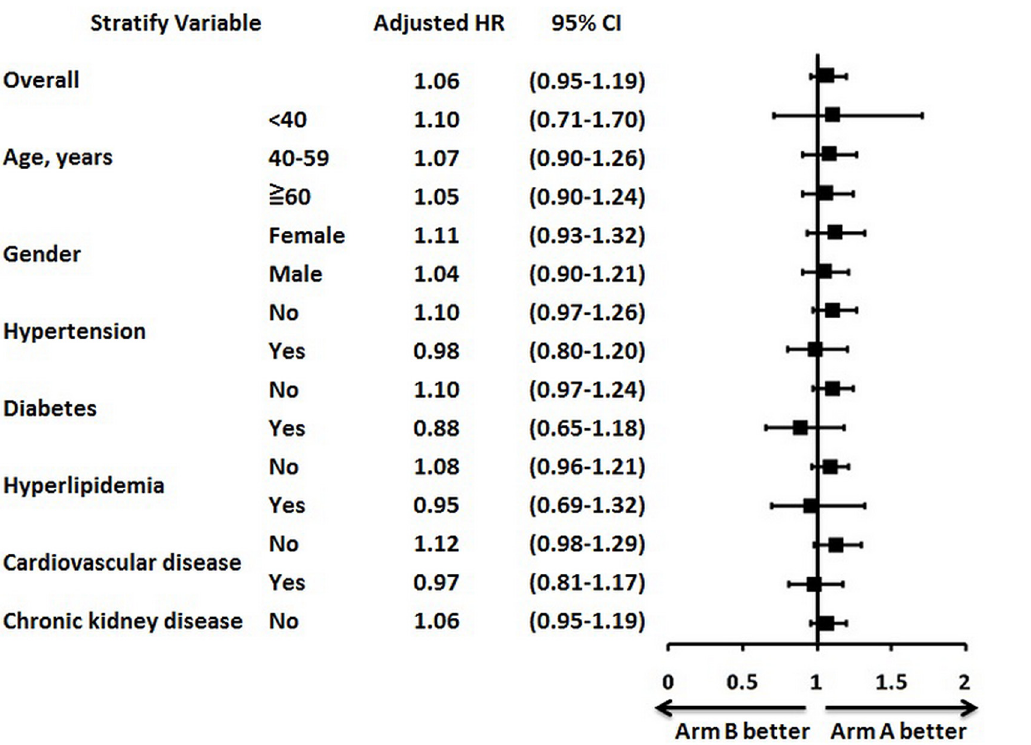
Fig 3. Subgroup analyses of overall survival for oxaliplatin followed by irinotecan-based regimens versus the reverse sequence. The overall hazard ratio (HR) for oxaliplatin followed by irinotecan-based regimens (arm A) versus the reverse sequence (arm B) was 1.06 (95% confidence interval [CI]: 0.95 − 1.19; p = 0.27). Age, gender, hypertension, diabetes, hyperlipidemia, cardiovascular disease, and chronic kidney disease were not independently associated with better overall survival in patients receiving either chemotherapy